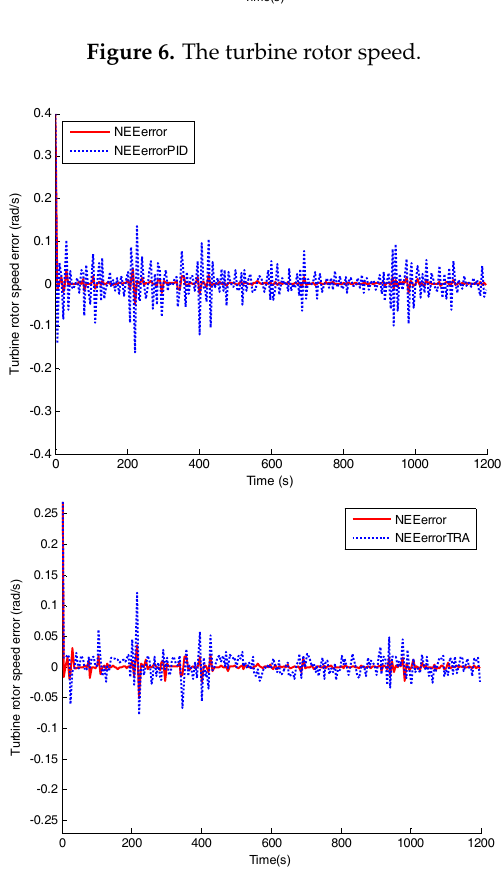
Figure 7. Turbine rotor speed error.